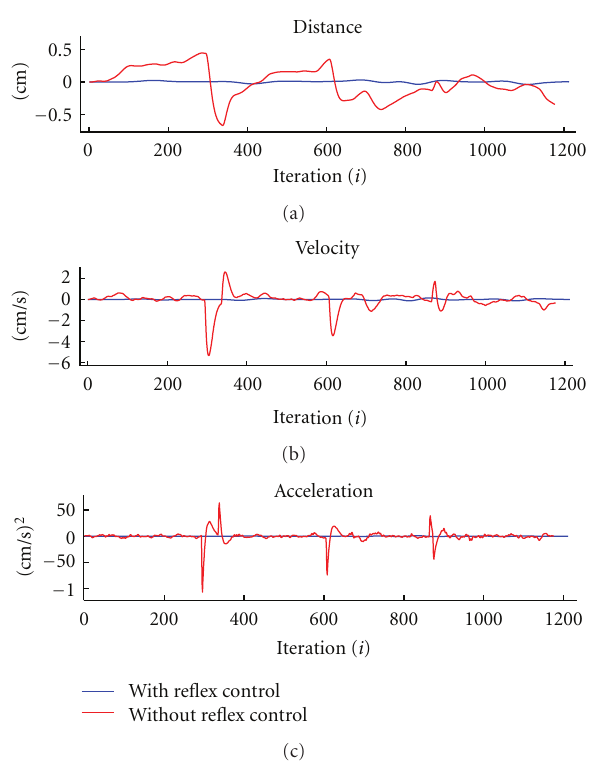
Figure 19: A comparative representation of disturbance estimation with and without using the proposed FRC